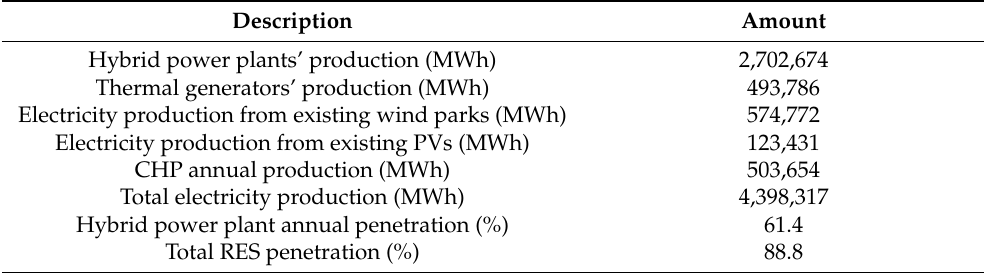
Table 13. Annual electricity production analysis in Crete with the newly configured demand